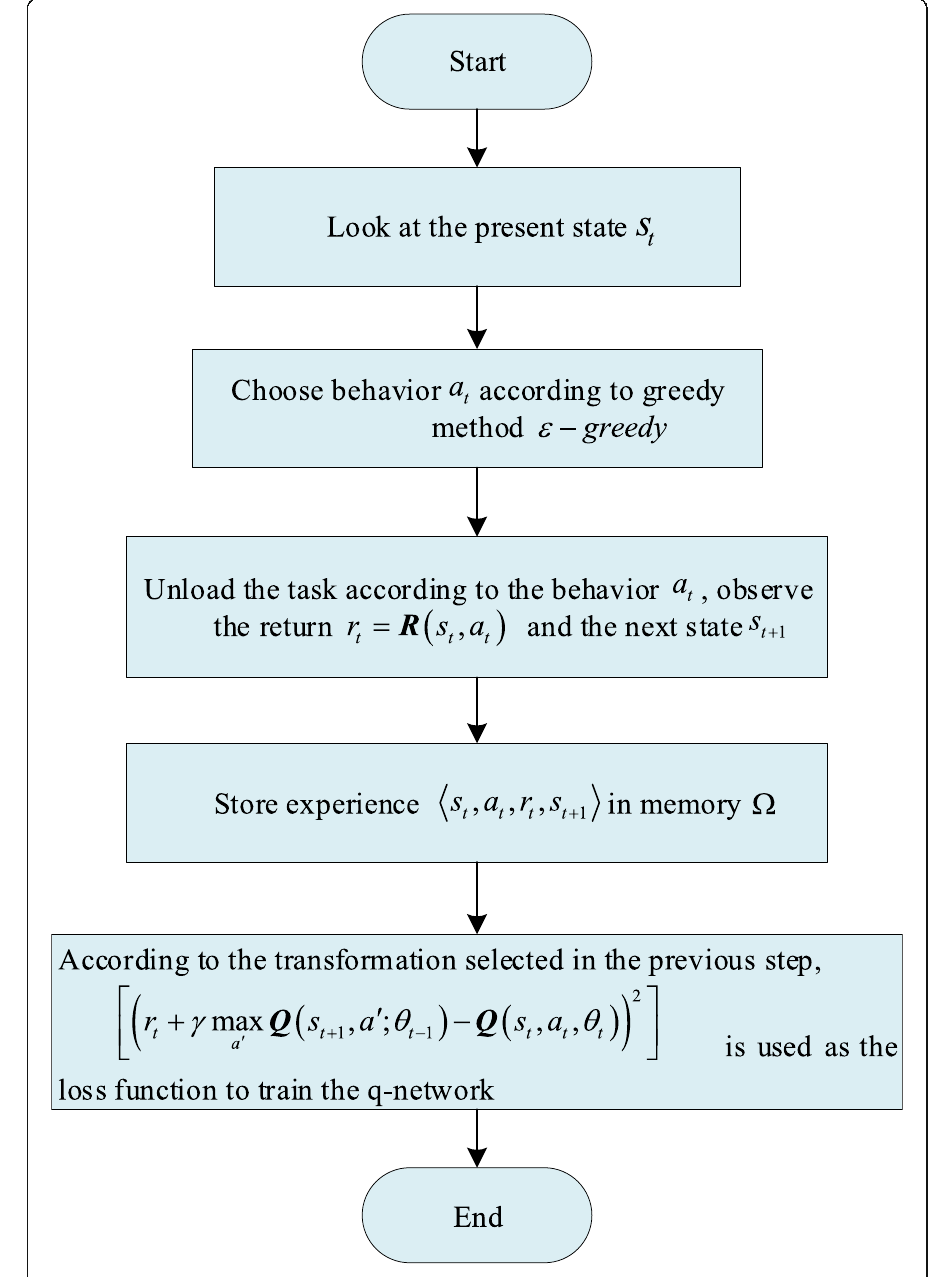
Fig. 2 Offloading decision algorithm based on